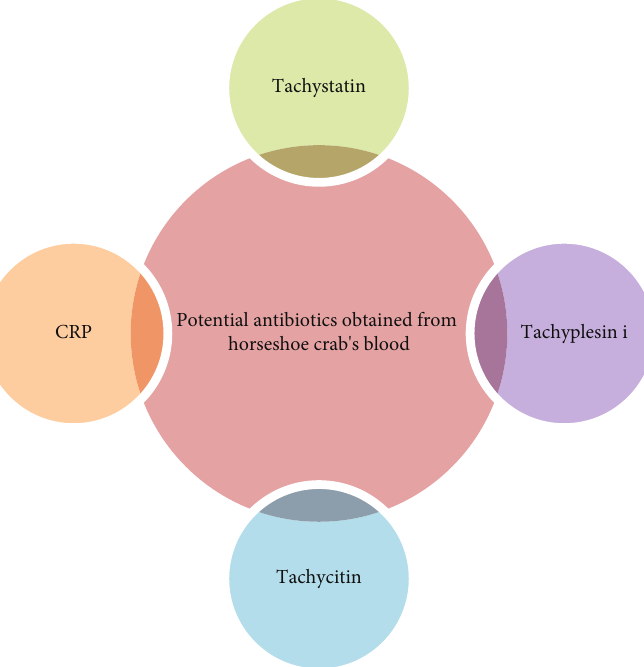
Figure 11: Potential antibiotics obtained from horseshoe crab ’ s blood.